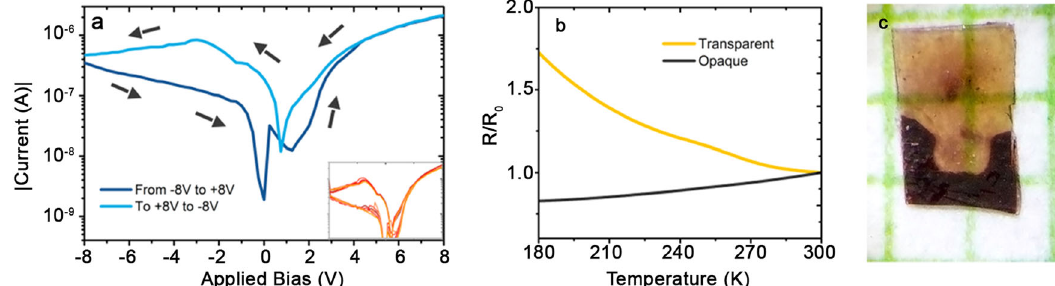
Fig. 3 Correlation between electrochromism and rectifying behavior of BL fi lms. a Cyclic I-V curves showing a diode-like behavior during the discoloration-coloration processes. Inset: eight cyclic I-V curves demonstrating the stability of the system. b Normalized temperature dependent resistance of the transparent (semiconducting) and opaque (metallic) fi lm. c Optical image of the partially discolored fi lm at ambient conditions showing its